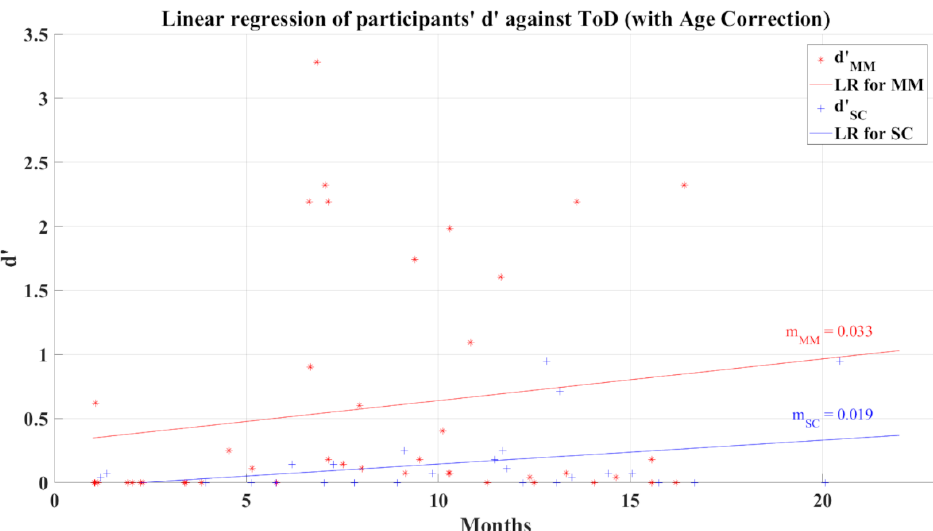
Figure 17. Linear regression of participants’ d’ versus elapsed time of diagnosis with corrected age-